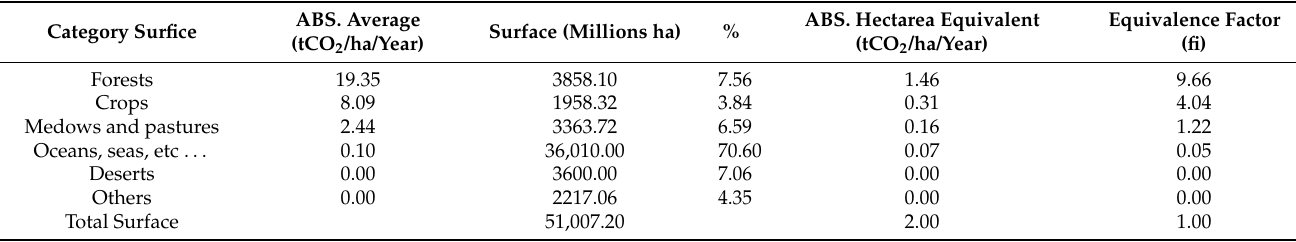
Table 2. Average and equivalent CO 2 absorption per hectare of the different surfaces of planet Earth. Surface area equivalence factors. Category